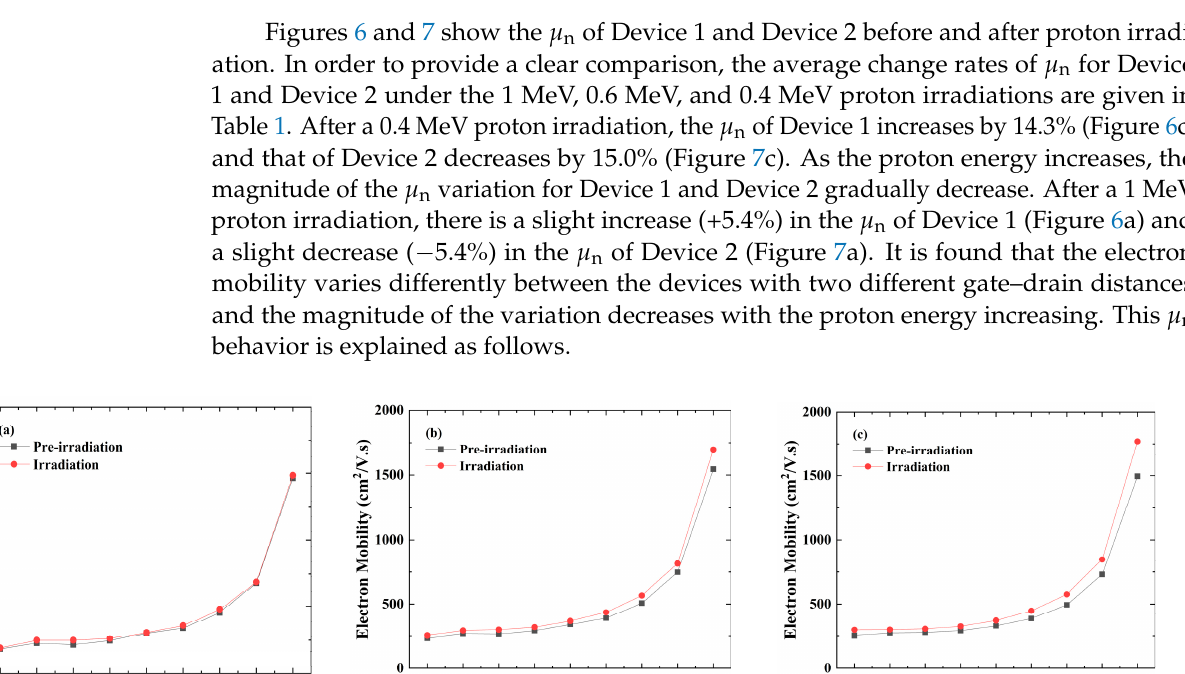
Figure 5. Measured I DS – V DS curves of Device 2 before (“Pre-irradiation”) and after (“Irradiation”) proton irradiation with 1 MeV ( a ), 0.6 MeV ( b ), and 0.4 MeV ( c ) proton energies.